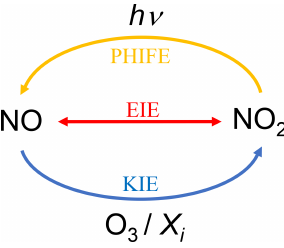
Figure C1. Sketch of the nitrogen fractionation processes between NO and NO 2 . PHIFE represents the photochemical isotope frac- tionation effect, KIE represents the kinetic isotope effect, and EIE represents the equilibrium isotope